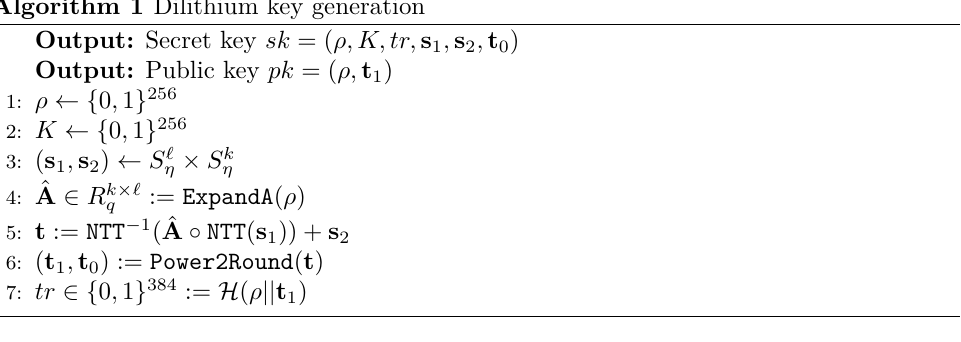
Algorithm 1 Dilithium key generation